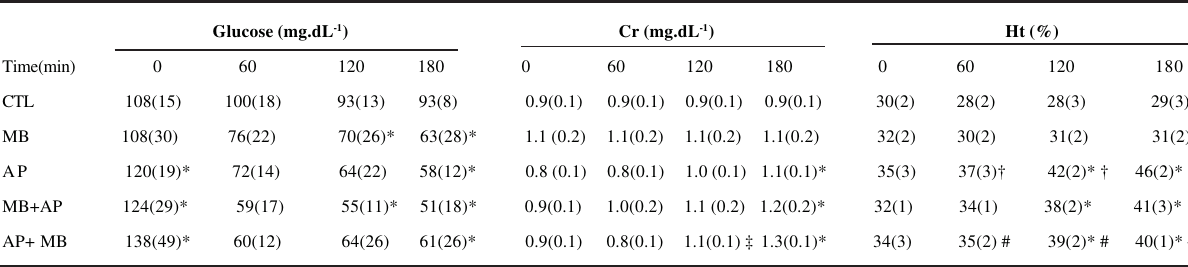
TABLE 3 - Serum glucose, creatinine and hematocrit results in all groups. Glucose (mg.dL -1 ) Cr (mg.dL -1